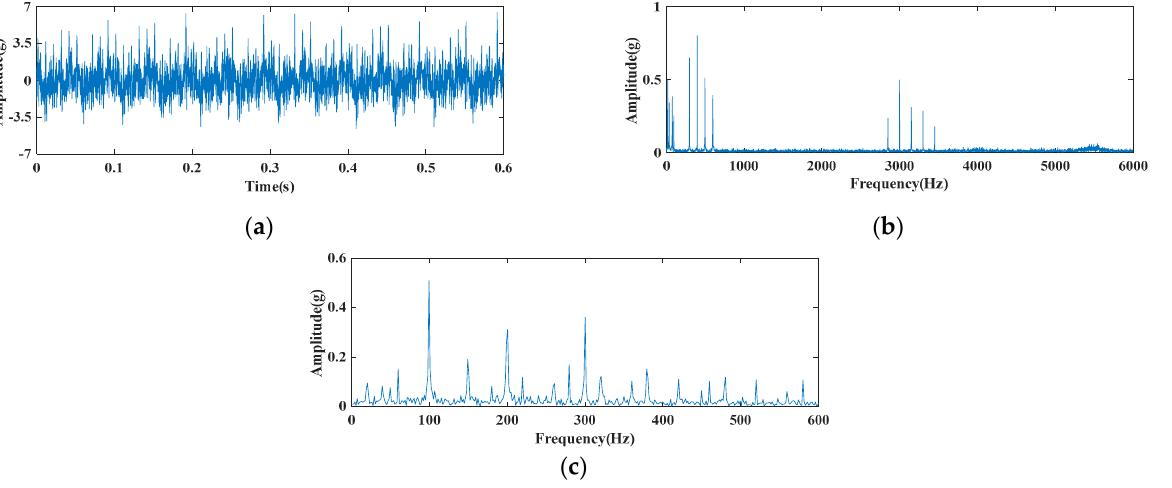
Figure 3. Simulated signal: ( a ) waveform; ( b ) frequency spectrum; ( c ) envelope